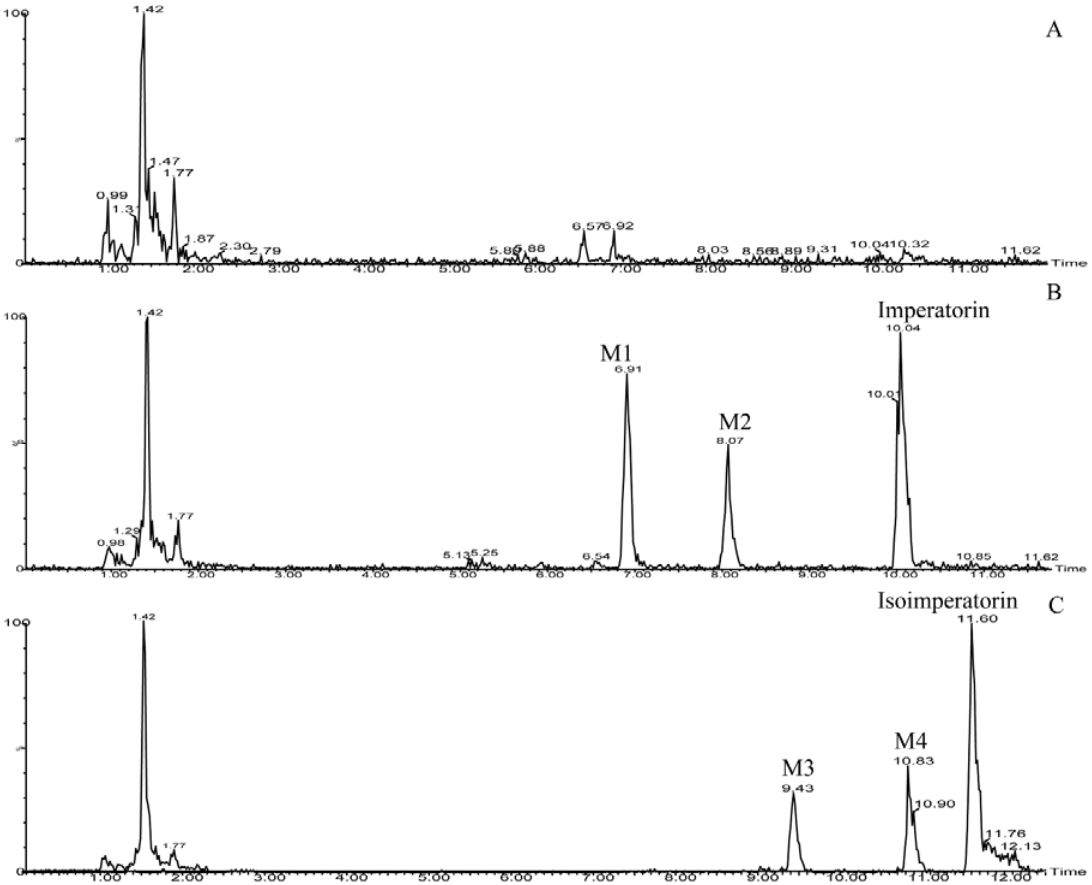
Figure 3. Ultra ‐ performance liquid chromatography–mass spectrometry combined with electrospray Figure 3. Ultra-performance liquid chromatography–mass spectrometry combined with